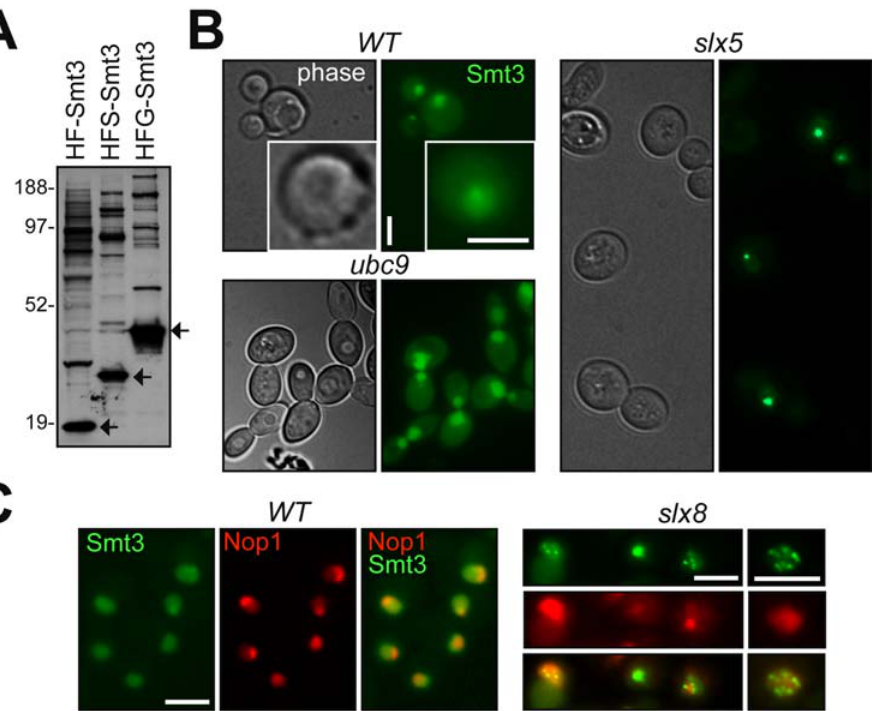
Figure 1. Smt3p conjugates are enriched in the nucleolus. (A) Alternative tagging of Smt3p expressed at the native levels enables the identification of sumoylated proteins. Total sumoylated proteins were purified by IMAC from the strains expressing wild-type levels of poly-His/FLAG- tagged Smt3p (HF-Smt3, 924-YPH499b), poly-His/FLAG/S-tag-Smt3p (HFS-Smt3, 1008-YPH499), and poly-His/FLAG/GFP-Smt3p (HFG-Smt3, 1014- YPH499. Sumoylated proteins here and thereafter are separated by PAGE and detected by Western-blotting using the anti-FLAG antibody. Arrows indicate the proportional size shifts between the free SUMO forms. Molecular weight markers ( 6 1000) are shown on the left. (B) GFP-SUMO localization as a function of conjugation/de-conjugation. The wild type (1014-YPH499b), ubc9-1 (1cYT630), and slx5 D (1dYT631) strains expressing GFP-Smt3p as in (A) were incubated at 32 u C (semi-permissive for ubc9-1 ) for 5 h and imaged live. The insert shows gradient-like distribution of SUMO typical for wild type, which is noticeable at higher magnifications. Scale bars here and elsewhere are 5 m m. (C) SUMO conjugates are concentrated in the nucleolus in slx8 D cells. The wild type (1014-YPH499) and slx8 D (1aYT629) strains co-expressing GFP-Smt3p and Nop1p-mRFP were incubated at 30 u C; cell images were captured